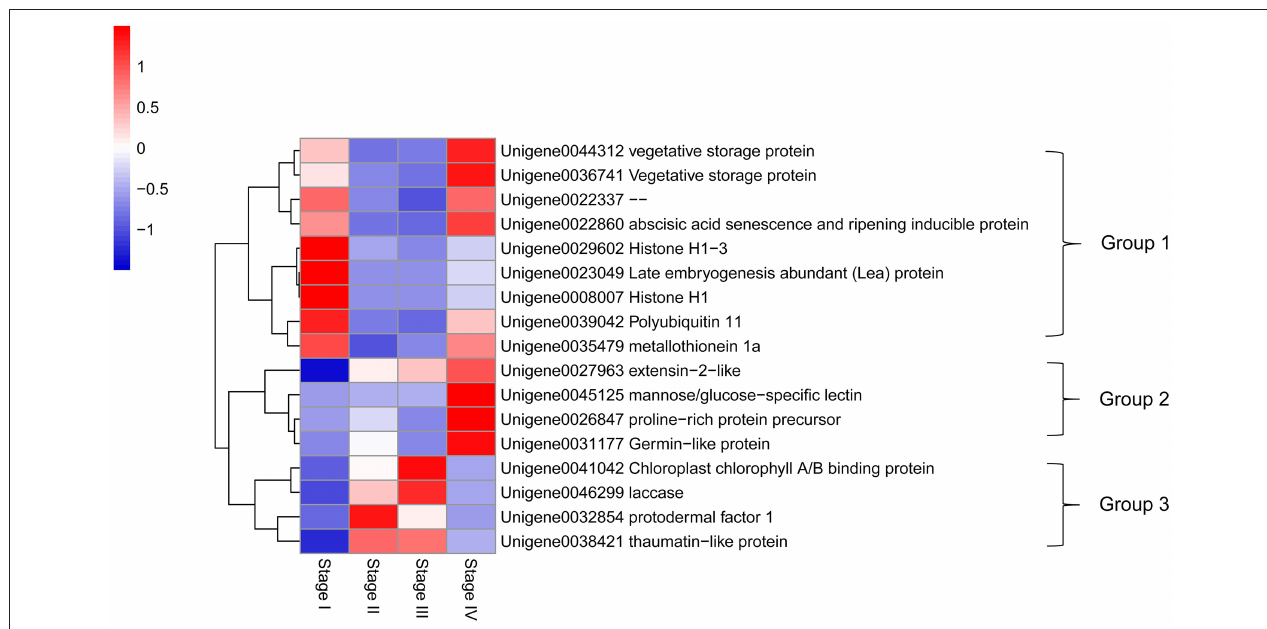
FIGURE 7 | Heat map diagram of relative expression levels and classification based on the expression patterns of the major genes with either PC1 or PC2 scores higher than